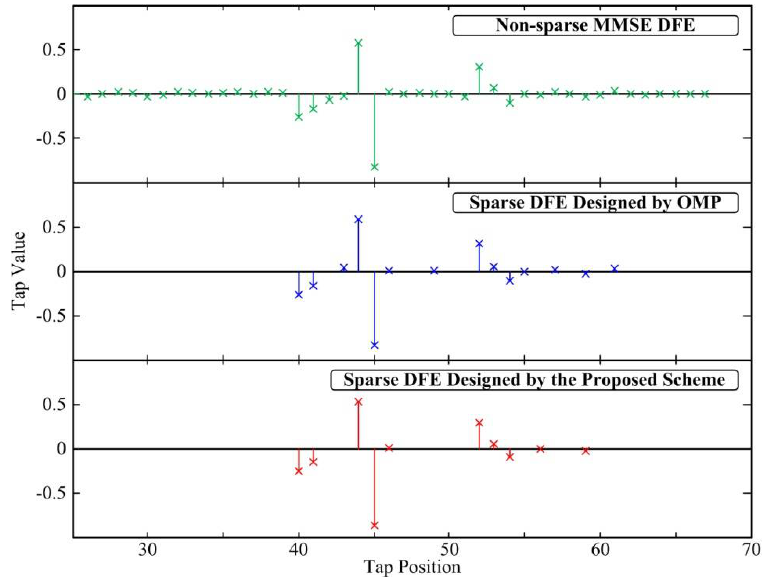
Figure 2. Single example of the SISO DFE by the three design method in Vehicular A channel with η max = 0.6 dB, SNR = 20 dB and N f = 25. Sensors 2018 , 18 , x